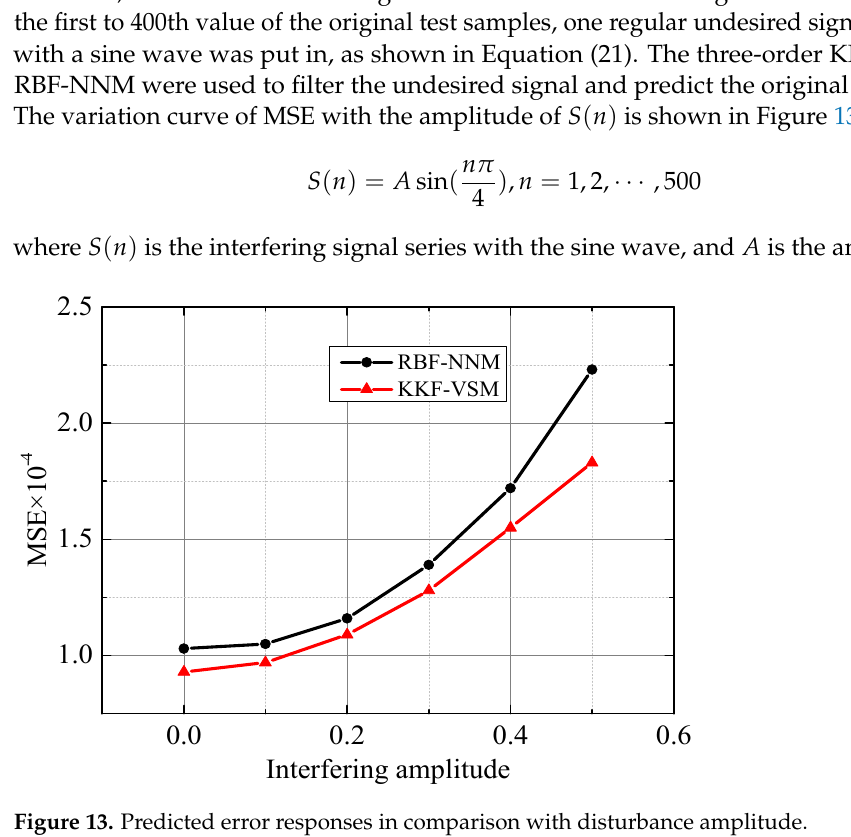
Figure 13. Predicted error responses in comparison with disturbance amplitude. As seen in Figure 13, when the strength of undesired signals was the same, the MSE of KKF-VSM was smaller than that of RBF-NNM. In addition, the gradient of the KKF- VSM curve was also smaller than that of the RBF-NNM one. These results imply that the robustness of RBF-NNM was poor when the undesired signals were strong. In comparison, the KKF-VSM showed a more robust performance because KKF-VSM contained both the linear and the nonlinear components at the same time. When the order of KKF-VSM changed, the contribution of each part to the method’s robustness was analyzed, as shown in Table 2. From it, we can see that MSE decreased when KKF-VSM changed from one order to two orders. That implies the second component of KKF-VSM could express the most nonlinear characteristic of the test sample. Furthermore, when the KKF-VSM changed from two orders to three orders, the gradient of MSE obviously decreased, implying that the three-order component provided a clear contribution to the robustness. Table 2. Influence of Volterra orders on the robustness.